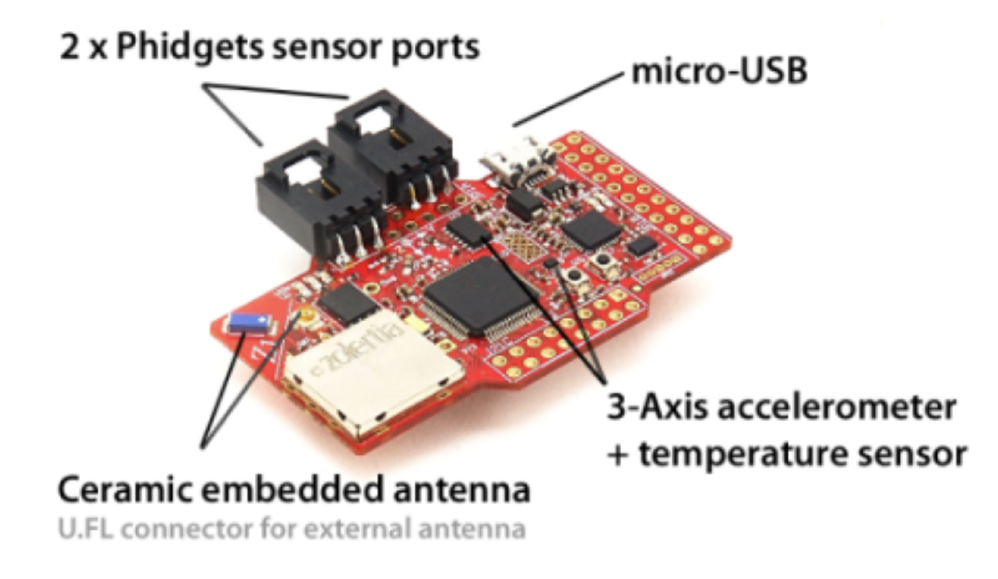
Figure 6. Z1 IoT